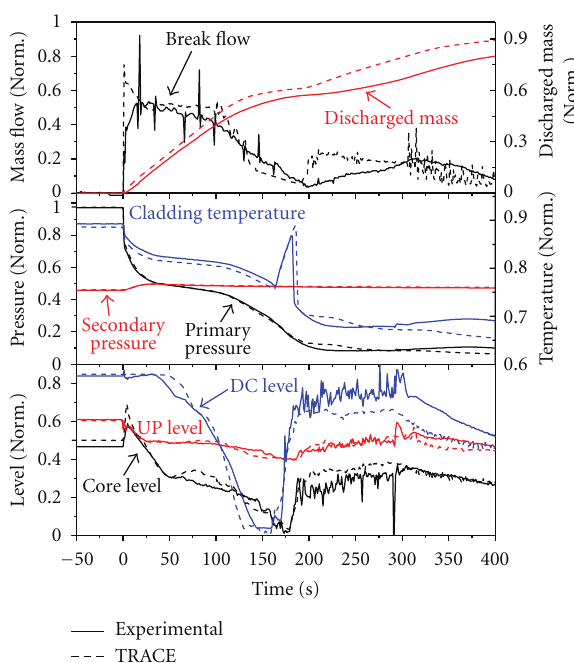
Table 7: Chronology of the main events in Test 1 [10].